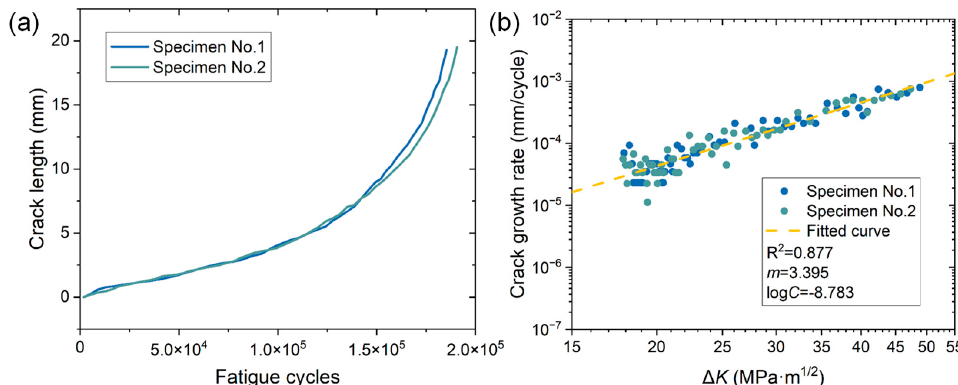
Figure 3. ( a ) Fatigue crack length and crack growth rate versus fatigue cycles of 2.25Cr1Mo0.25V steel. ( b ) Fatigue crack growth rate versus stress intensity factor range ( Δ K ) in the double logarithm coordinate.